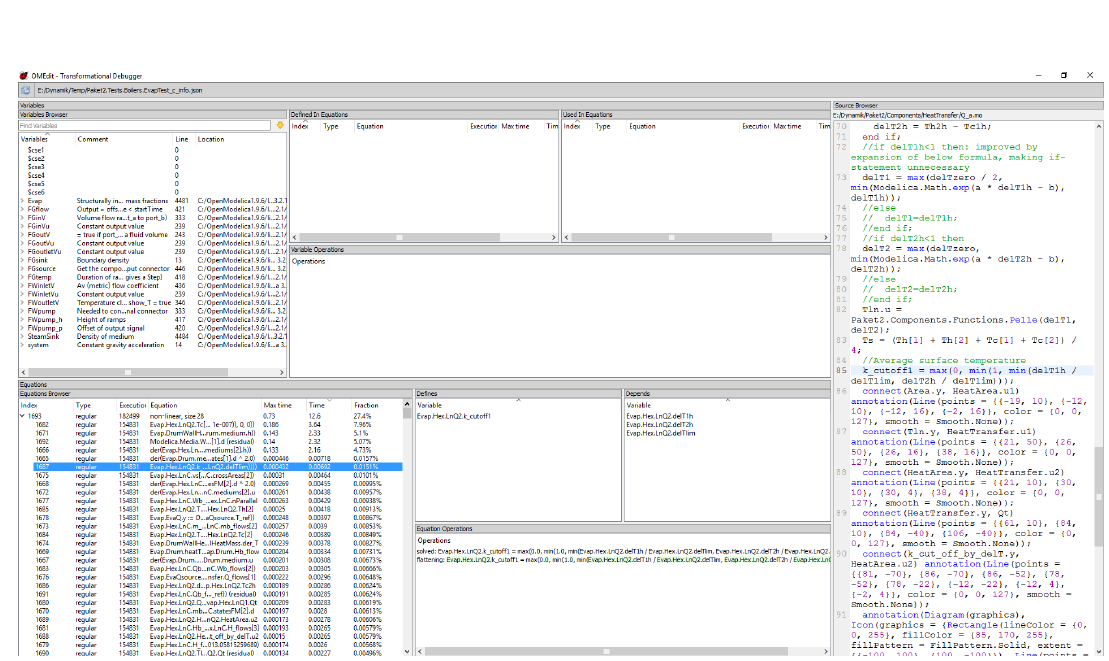
Figure 14: Performance pro(cid:28)ler output after a minor model adjustment. See also close-up in the Figure 15.